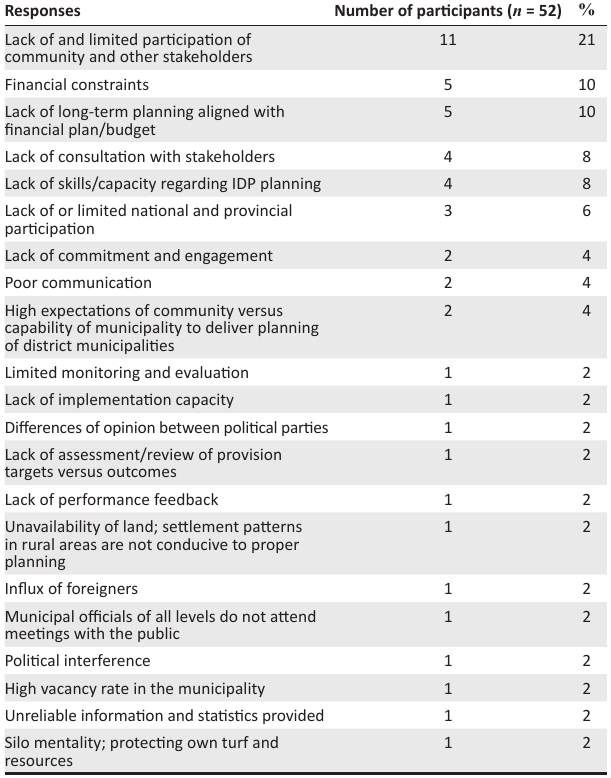
TABLE 6: Main integrated development plans challenges and limitations. Responses